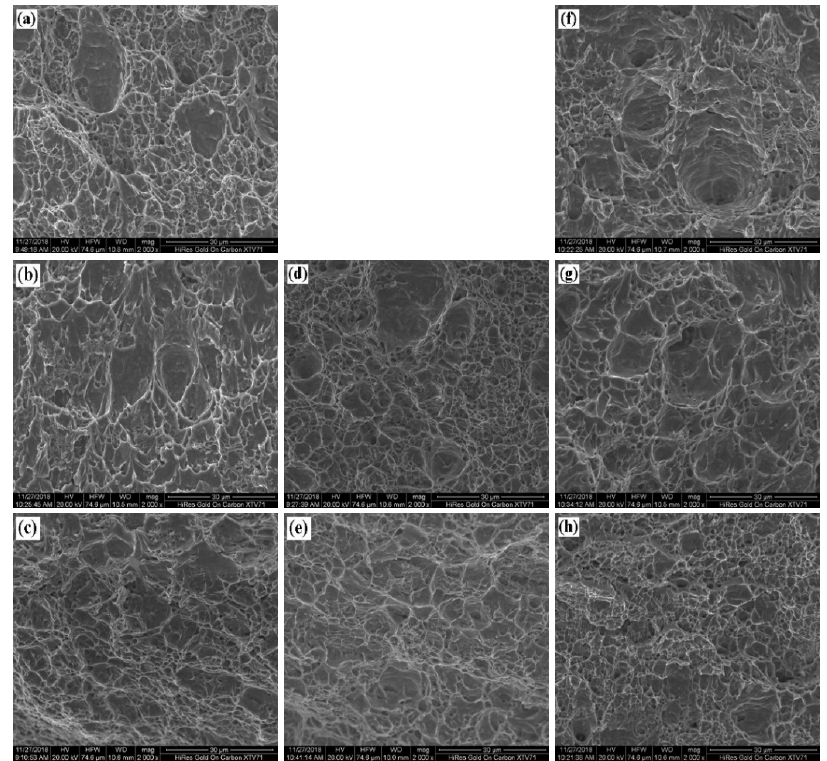
Figure 11. Impact fractographs of the fibrous zone at the different temperature measurement points. Images ( a – h ) exhibit the results for points P1-P8, respectively.